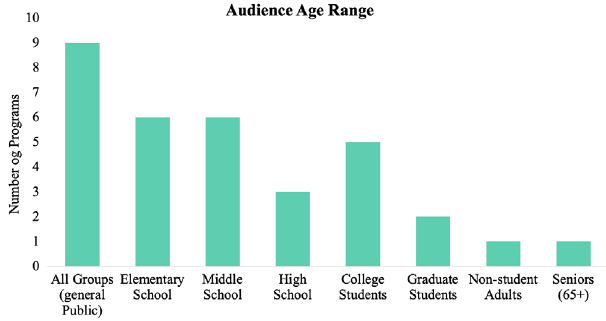
attract.FIG. 11. Distribution of the audience age ranges in different programs in the